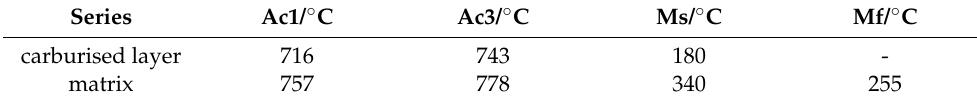
Table 2. The phase transition temperature points of the carburised layer and the matrix.